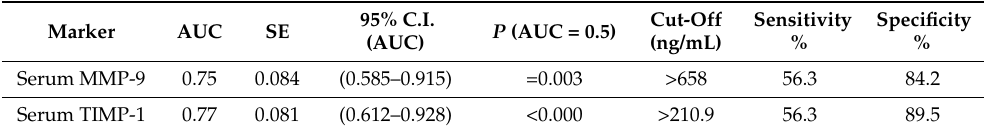
Table 5. Diagnostic performance of MMP-9 and TIMP-1 in differentiating Right-sided UC and Left-sided UC.